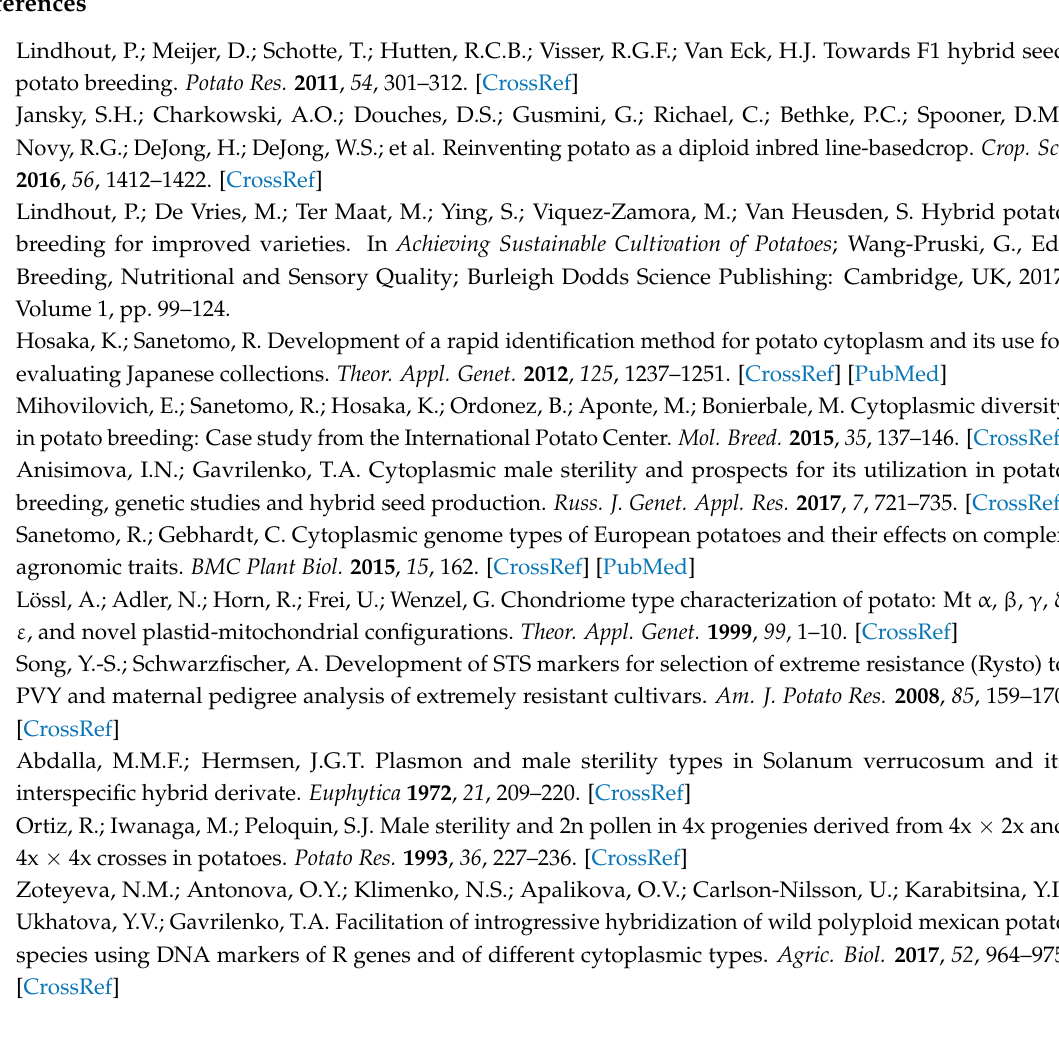
Figure S1: Clusterization of metabolite profiles of anthers at the mature pollen stage from male-fertile and male-sterile potato genotypes, Figure S2: RF classification with ratios of metabolites concentrations, Figure S3: Meiosis in PMC of S. tuberosum – male-fertile (cv. Lomonosovskij) and male-sterile genotypes (cv. Sudarynja, cv. Gusar), Figure S4: Typical fluorescence spectra obtained from non-stained (a) and stained (b) with aniline blue pollen, Table S1: Arbitrary concentrations of metabolites in anthers of sterile and fertile varieties of S. tuberosum , Table S2: Characteristics of meiosis in S. tuberosum male-sterile and -fertile varieties, Table S3: Morphological parameters of pollen grains in genotypes differed in its fertility/sterility